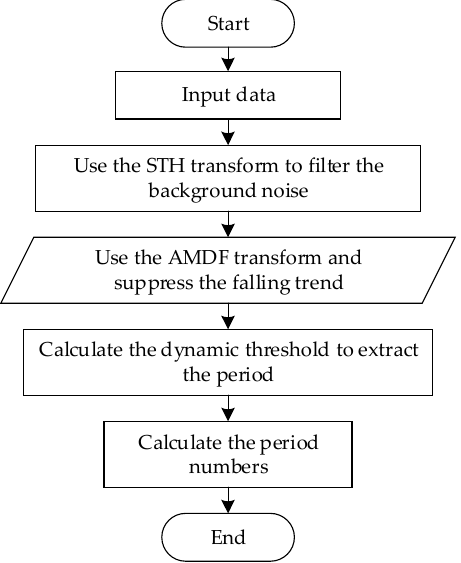
Figure 2. The flow chart of the peak detection method based on AMDF and STH algorithm.